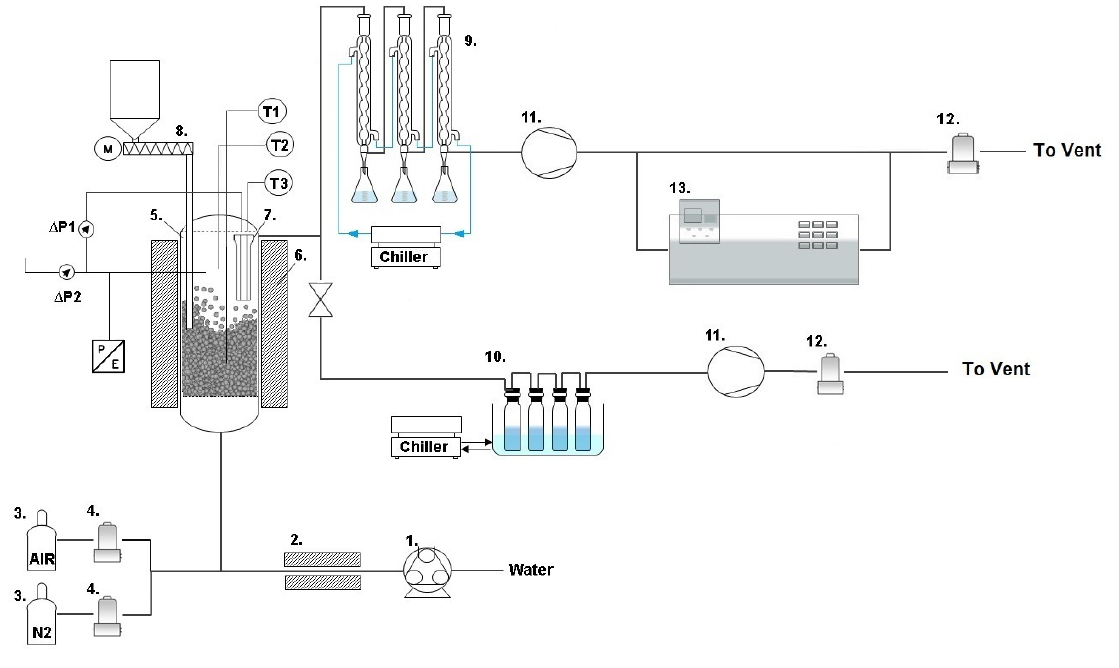
Figure 1. Scheme of the bench-scale gasification test rig. 1—water pump; 2—steam generator; 3—air and N 2 gas tanks; 4—air and N 2 mass flow controllers; 5—bubbling fluidized-bed gasifier; 6—electric furnace; 7—ceramic filter candle (OD of 60 mm, length of 440 mm); 8—screw conveyor for feeding fuel; 9—heat exchangers for steam condensation; 10—tar sampling unit; 11—vacuum pumps; 12—syngas